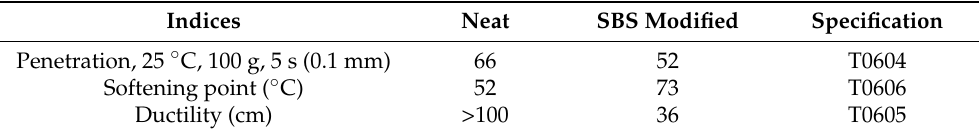
Table 4. Technical properties of the asphalt